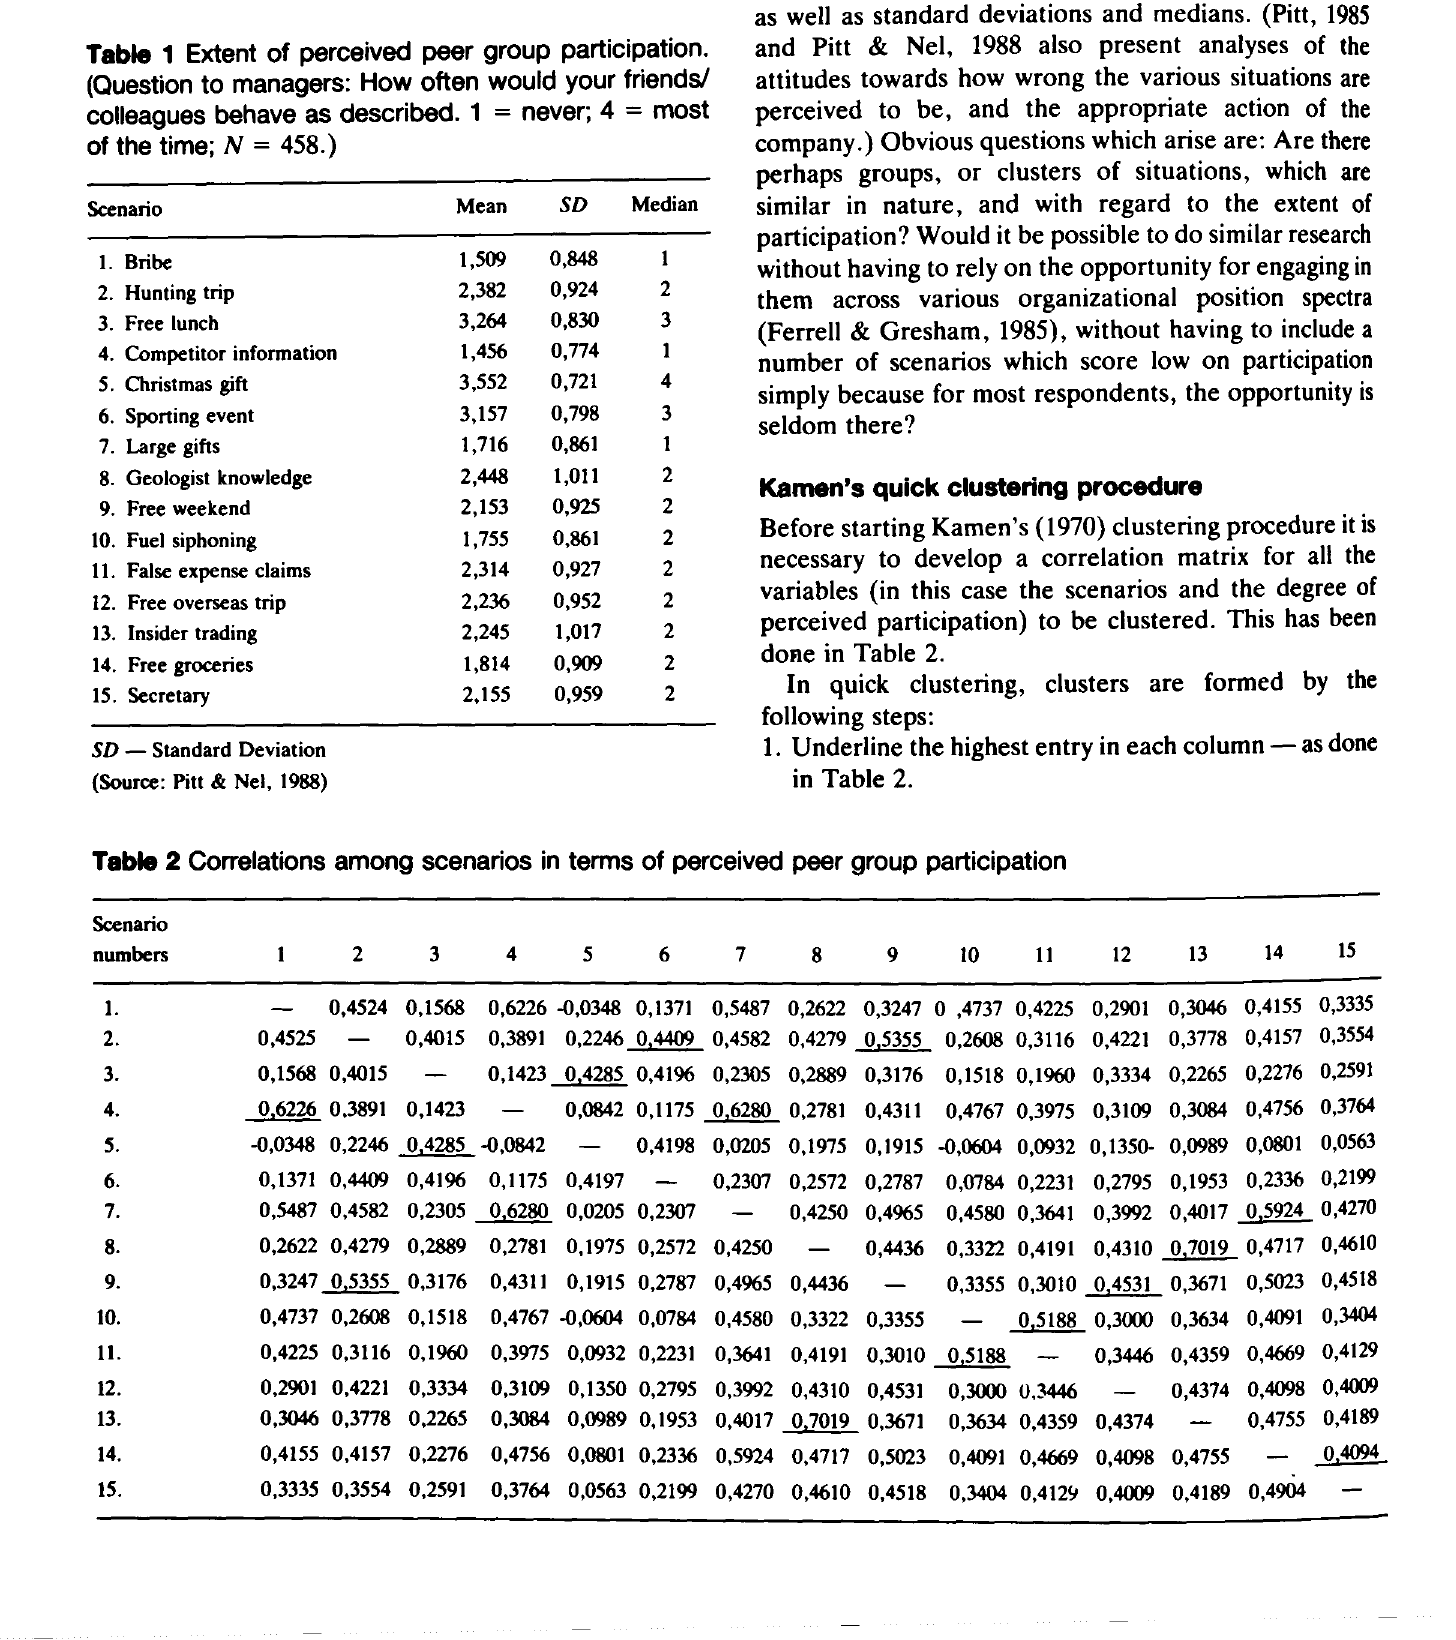
Table 1 Extent of perceived peer group participation.